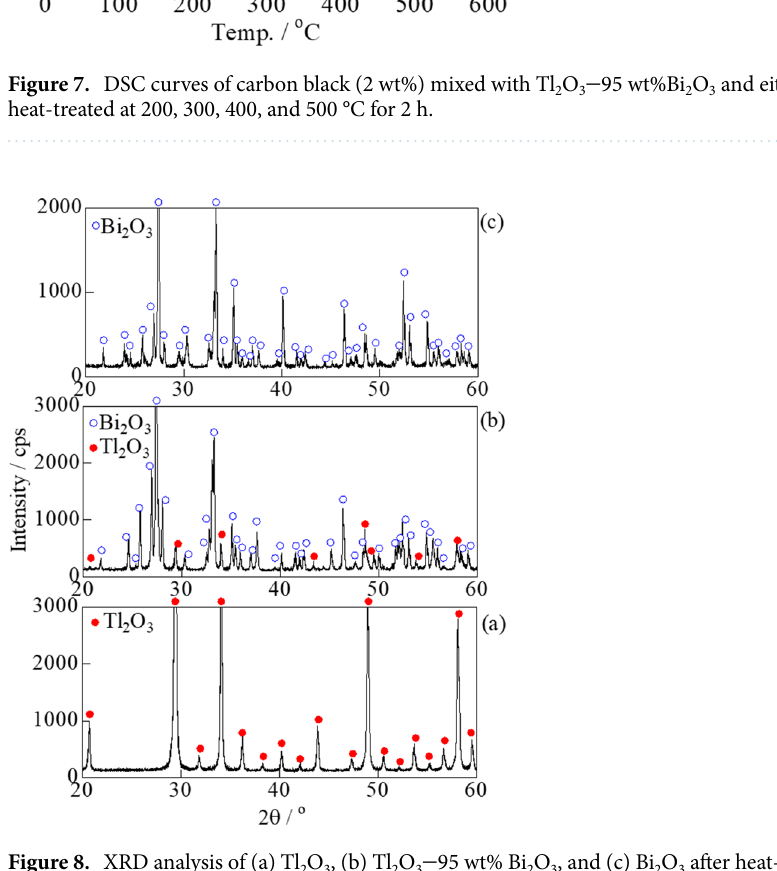
Figure 8. XRD analysis of (a) Tl 2 O 3 , (b) Tl 2 O 3 ‒ 95 wt% Bi 2 O 3 , and (c) Bi 2 O 3 after heat-treatment at 500 ℃ for 2